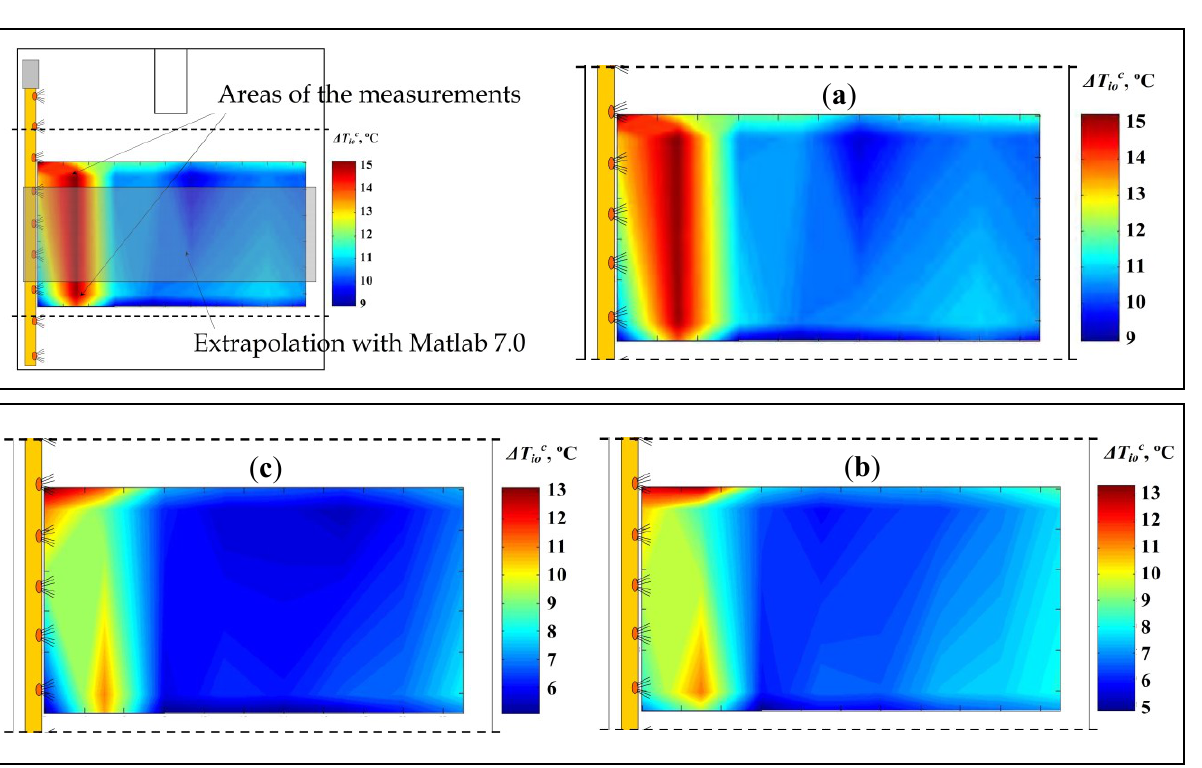
Figure 9. Difference in corrected air temperature ( ΔT ioc ) in greenhouse 1 (heated) at 0.8 m height. Tests 1 ( a ), 2 ( b ) and 3 ( c